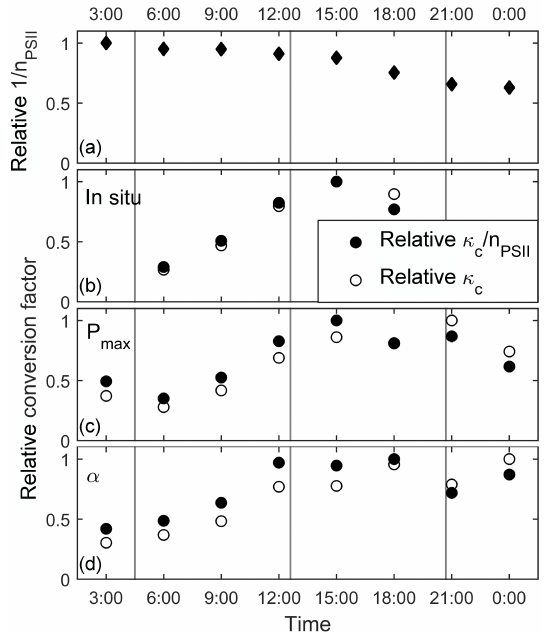
Figure 4. Relative changes in the components of the conver- sion factor K c /n PSII over the diurnal cycle. Panel (a) shows di- urnal changes in 1 /n PSII (molchl a molRCII − 1 ) , estimated as ( F o /σ PSII )/ [chl a ]. These relative values of 1 /n PSII were then used to derive relative values of K c (mole − molC − 1 ) from values of K c /n PSII . This was done for the conversion factor derived for in situ irradiances at 5m depth (b) , the conversion factor derived for light-saturated rates (c) , and the conversion factor for light-limited rates (d) . All values are scaled to 1 for